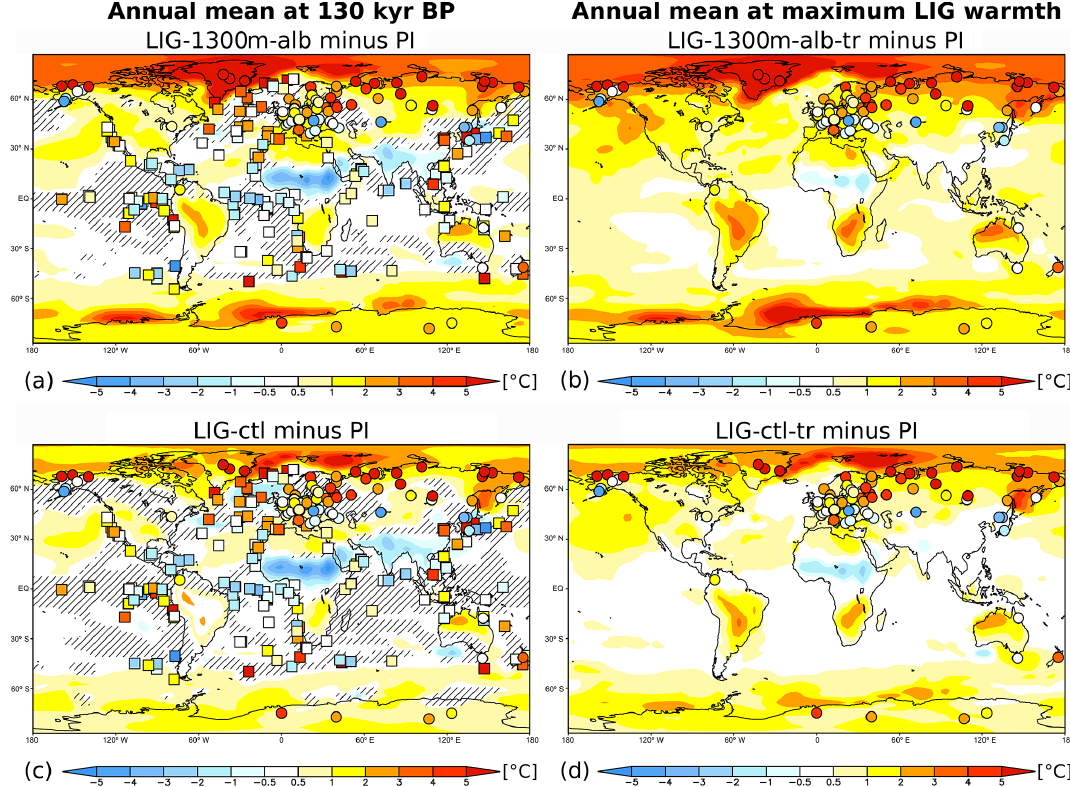
Figure 7. Effect of (a, b) Greenland Ice Sheet elevation, insolation, albedo, and atmospheric methane concentration and (c, d) insolation and atmospheric methane concentration for the Last Interglacial (LIG) relative to pre-industrial (PI). Model–data comparison of mean annual temperature anomalies. The shading represents the simulated surface temperature (TS) anomalies at (a, c) 130kyrBP derived from (a) LIG- 1300m-alb and (c) LIG-ctl, and (b, d) maximum LIG warmth (warmest 100 model years between 130 and 120kyrBP) derived from (b) LIG- 1300m-alb-tr and (d) LIG-ctl-tr, relative to PI. Hatched areas in (a, c) mark statistically insignificant TS anomalies. The squares and circles show marine and terrestrial proxy-based LIG annual mean temperature anomalies relative to present day (1961–1990) derived by Turney and Jones